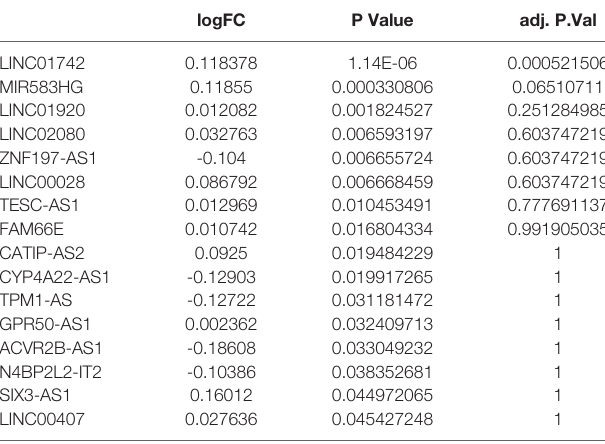
TABLE 3 | Differentially expressed and metastasis associated lncRNAs in ceRNA network.